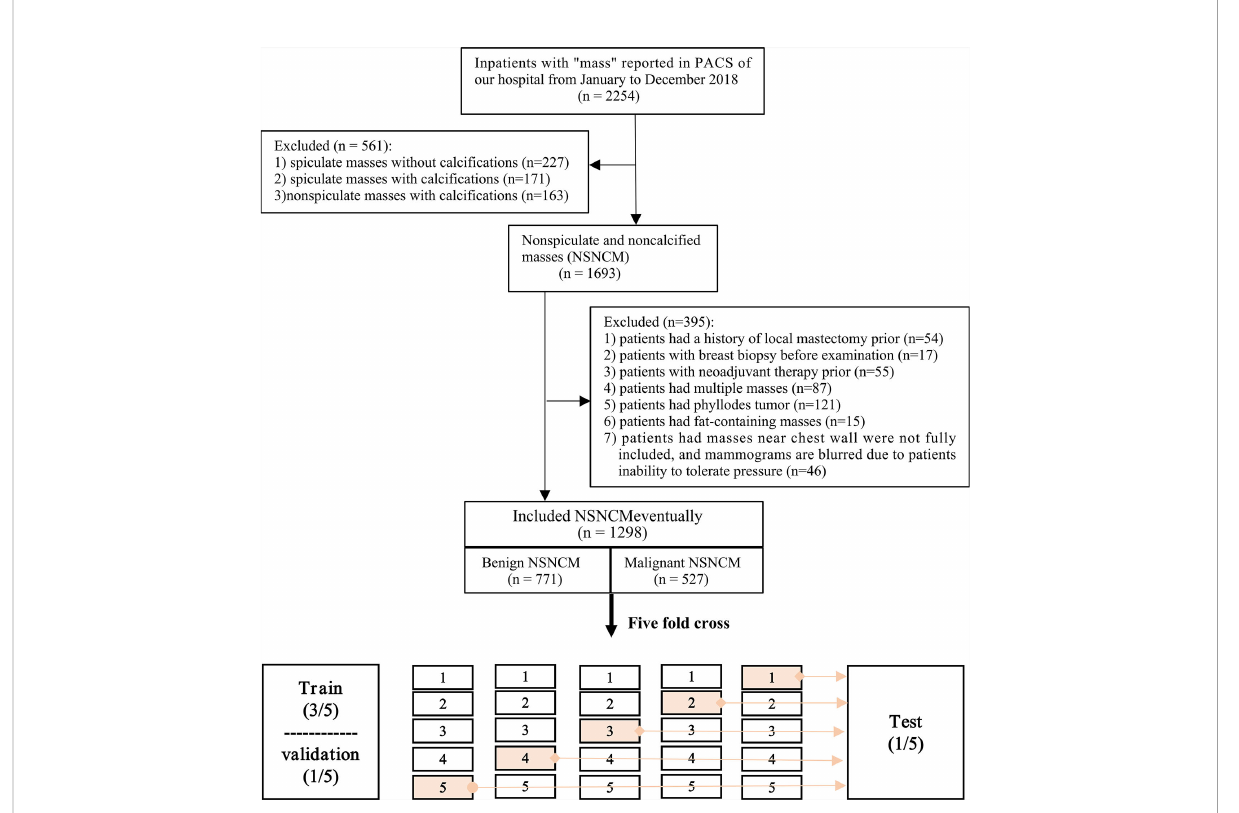
FIGURE 2 Flow chart of inclusion and exclusion of patients and division of data